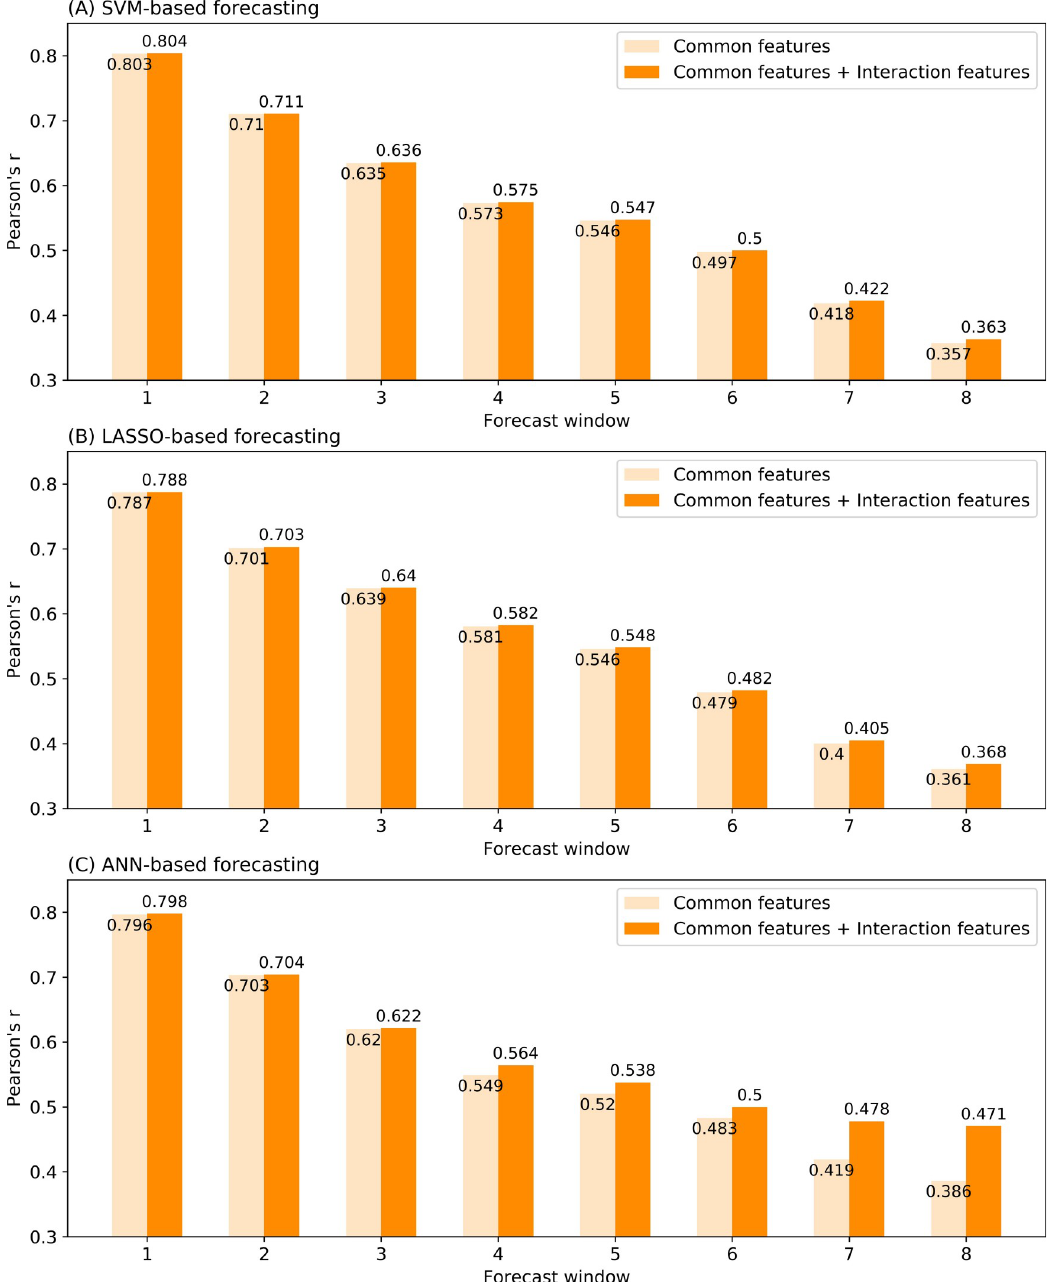
Fig 10. Performance comparison of models with and without interaction features based on the Pearson correlation coefficient of predicted and actual smoothed case counts. (A) SVM-based forecasting. (B) LASSO-based forecasting. (C) ANN-based